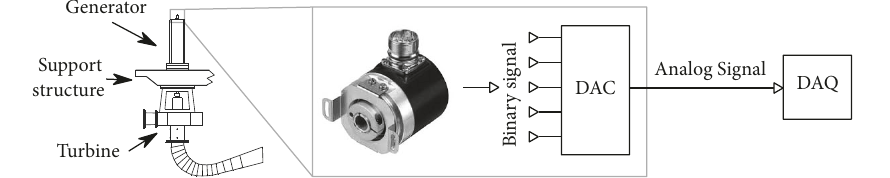
Figure 3: Absolute position sensor on the shaft end above the generator.